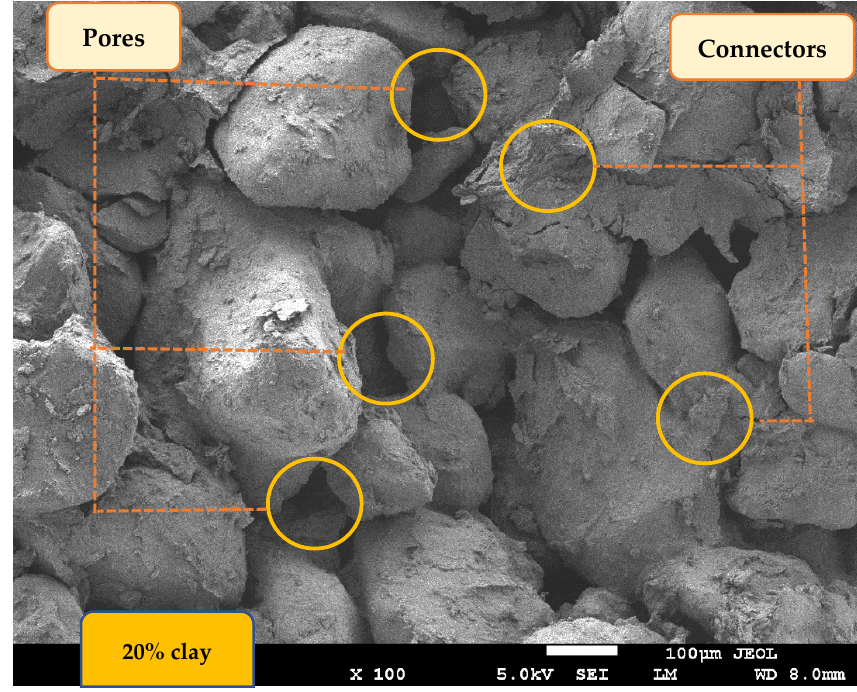
Figure 12. SEM of sand clay mixture with 20% clay content.